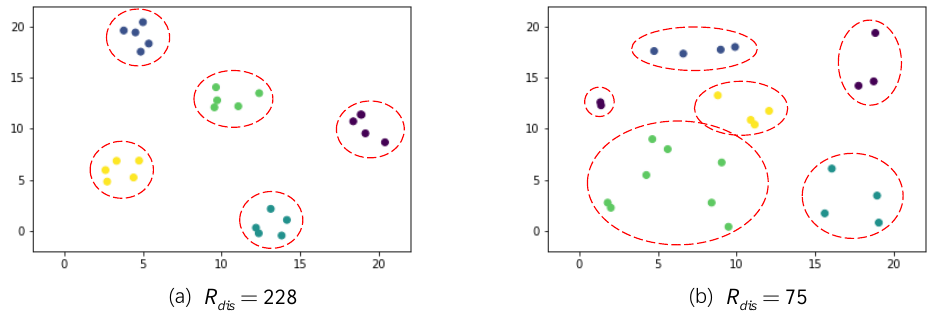
Figure 5. The dispersion reward results for two different clustering cases; ( a ) 20 artificially generated points; ( b ) 20 randomly generated points in a certain range. Different colors of points represent different